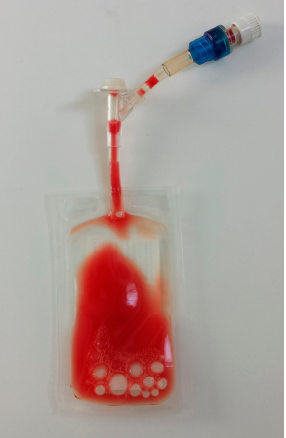
Figure 6. The final L-PRP inside the storage bag.